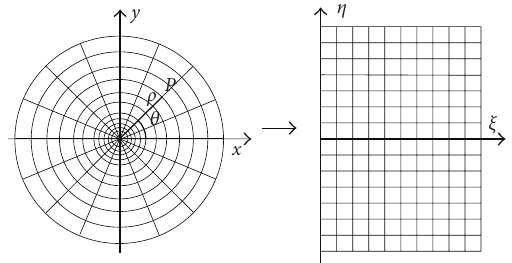
Figure 1: The log-polar mapping maps the radial lines and concen- tric circles into lines parallel to the coordinate